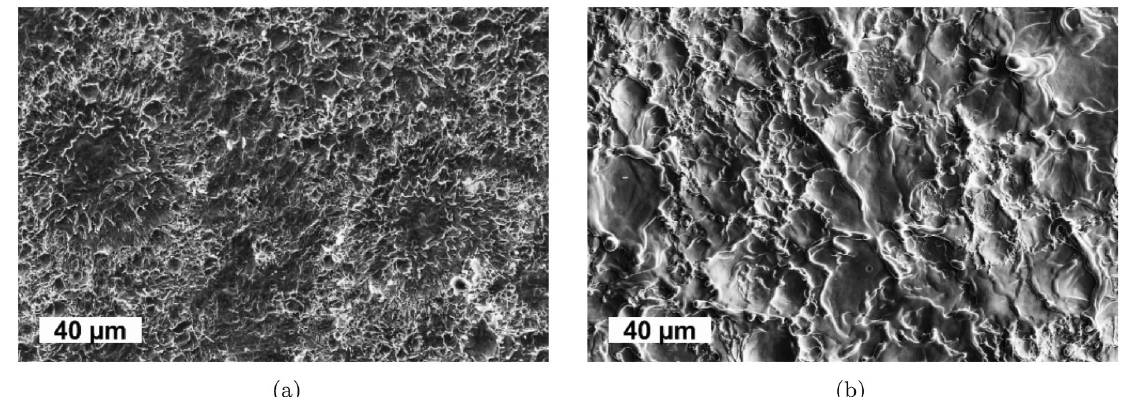
FIG. 9. SEM images of surface damage for Mo for low and high energy regimes. (a) Surface damage for C 1 ¼ 0 : 56 nF ( (cid:2) 10 mJ ); the total number of sparks on the spot was 96. (b) Surface damage for C 1 ¼ 27 : 5 nF ( (cid:2) 850 mJ ); the total number of sparks on the spot was 150.